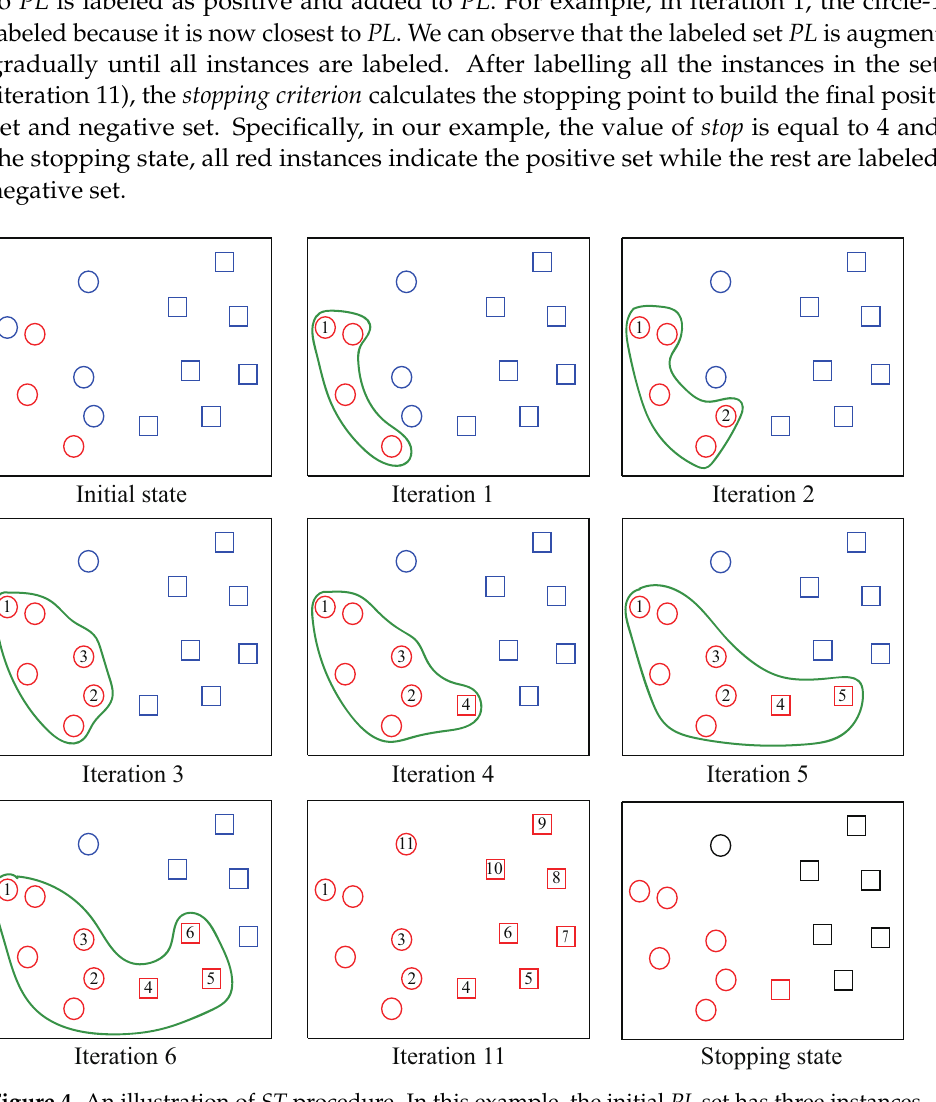
Figure 4. An illustration of ST procedure. In this example, the initial PL set has three